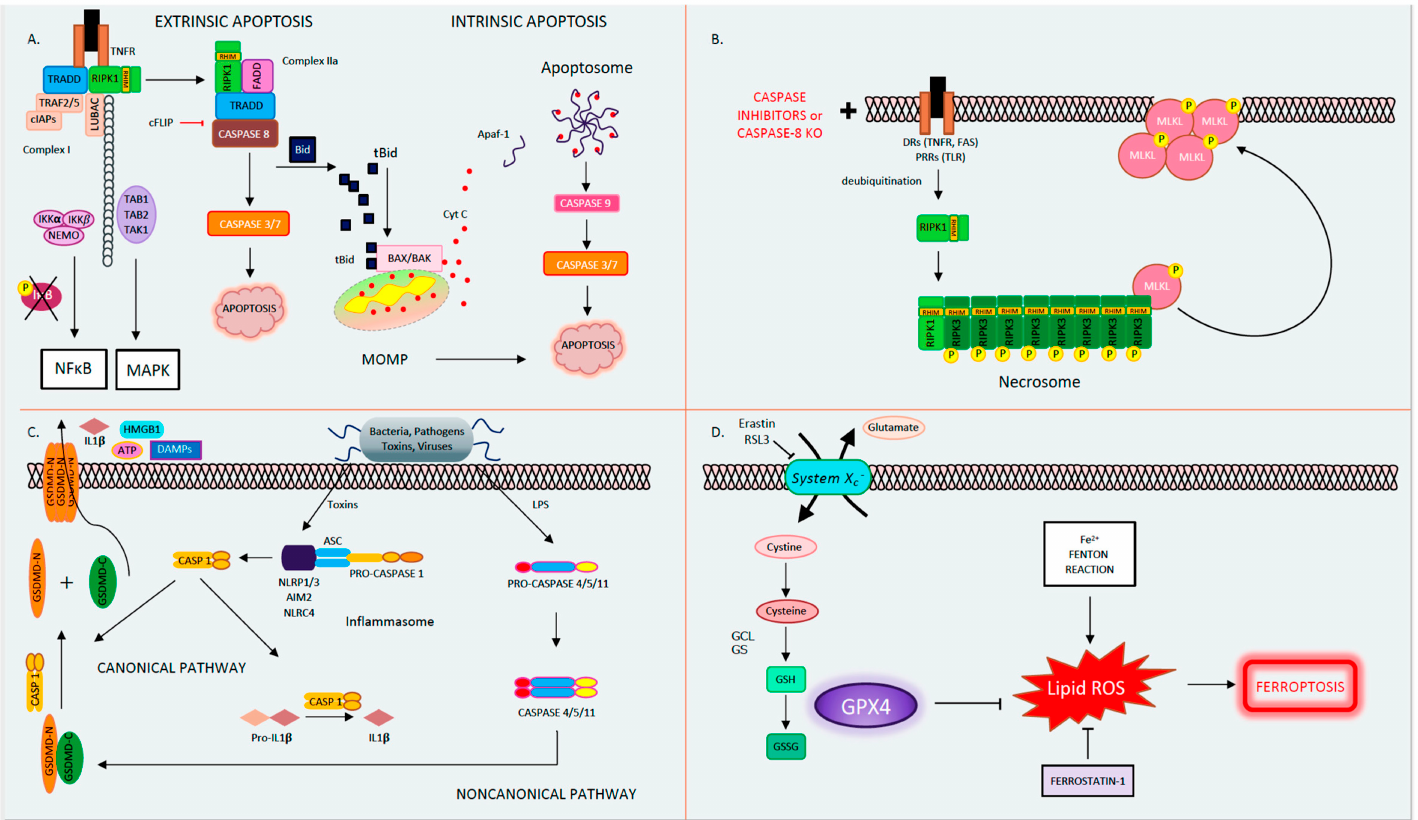
Figure 1. The four different types of regulated cell death. ( A ). Apoptosis. Apoptosis is a form of orderly programmed cell death, occurring both via an extrinsic and an intrinsic pathway. In the extrinsic pathway, after a DR is engaged (TNFR as an example depicted here) by its ligand (here, TNF), it oligomerizes and binds the adaptor TRADD, the E3 ubiquitin ligases TRAF2/5, cIAPs, and LUBAC, as well as the kinase RIPK1 to form Complex I. Then, RIPK1 becomes polyubiquitinated and serves as a scaffolding protein for the further recruitment of TAK1-TAB1/2 and IKK α / β -NEMO. TAK1 activates the MAPK pathway, while phosphorylation and the subsequent degradation of I κ B leads to NF κ B activation and the transcription of pro-survival/inflammatory genes. If RIPK1 is deubiquitinated, it forms Complex IIa, consisting of FADD, TRADD, RIPK1, and caspase 8. Caspase 8 becomes activated in Complex IIa, in turn activating its downstream executioner caspases 3 and 7, leading to apoptosis. In the intrinsic pathway, caspase 8 mediates the cleavage of Bid into tBid. tBid translocates to the mitochondria where it binds BAX/BAK, leading to MOMP and Cytochrome C release. Cytochrome C binds Apaf-1, releasing its auto-inhibitory hold and allowing for its oligomerization, apoptosome formation, and caspase 9 activation. In turn, caspase 9 activates the executioner caspases 3 and 7, leading to apoptosis. ( B ). Necroptosis occurs when death receptors (such as TNF and FAS) or pattern recognition receptors (such as TLR2/3) are activated in the presence of pan-caspase